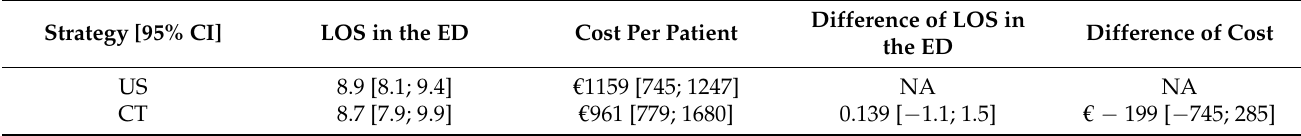
Table 3. Costs and effectiveness for each strategy of imaging (weighted endpoints).